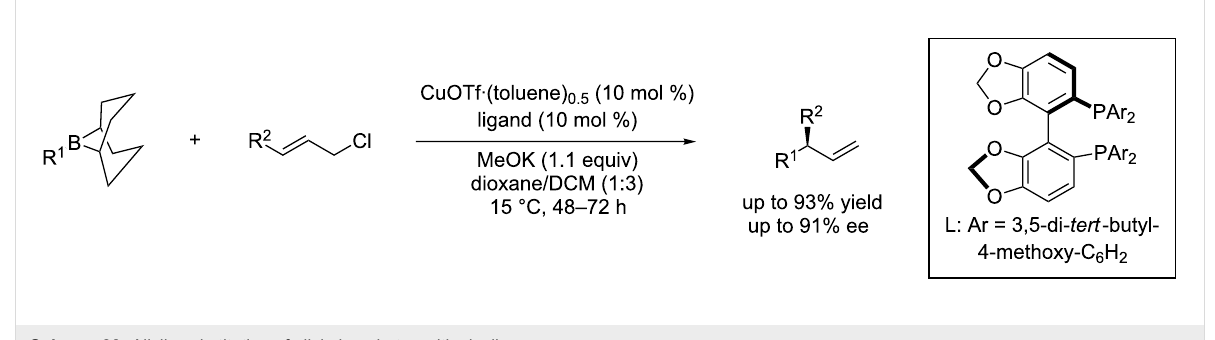
Scheme 28: Allylic substitution of allyl phosphates with